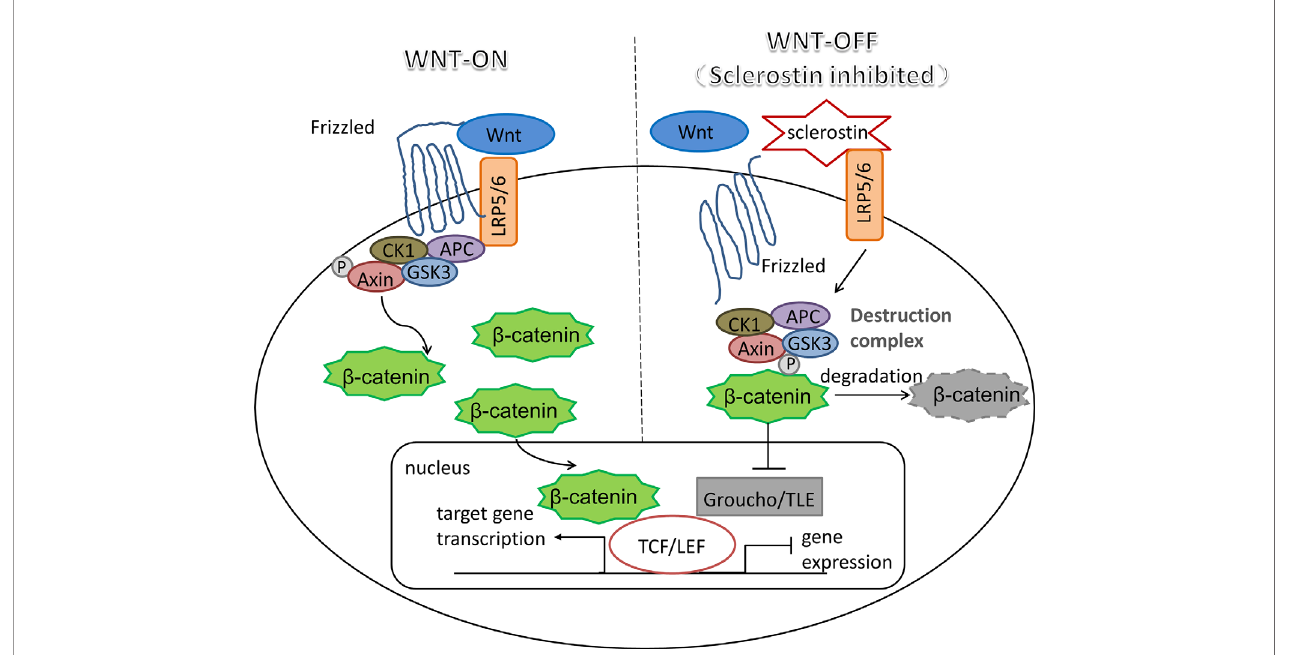
FIGURE 1 | Sclerostin: an inhibitor of canonical Wnt signaling pathway. Wnt-LRP5/6-Fz complex elicits a molecular cascade that transfer Axin-mediated destruction complex, which is essential to b -catenin degradation, to the plasma membrane. Increased b -catenin moves into the nucleus, where it represents the molecular mechanism that b -catenin binds to TCF/LEF, which are the main partners of b -catenin to serve the transcriptional function of canonical Wnt signaling pathway. Sclerostin inhibits Wnt signaling by binding competitively to LRP5/6, thereby promoting the degradation of b -catenin mediated by destruction complex, resulting in the interaction between TCF/LEF and repressor Groucho/TLE proteins to halt the expression of target